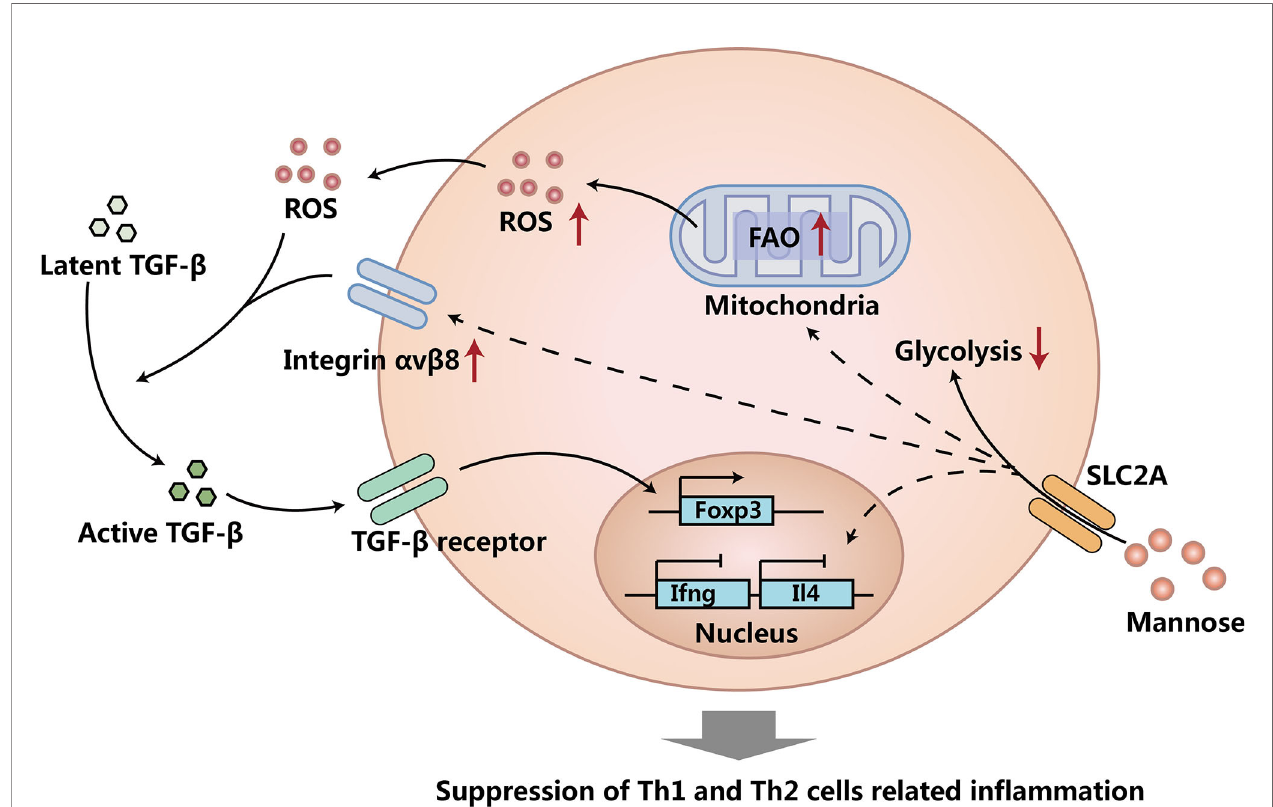
FIGURE 1 | Mannose induces Treg cells and suppresses Teff cells. Mannose suppresses glycolysis, increases fatty acid oxidation (FAO), and up-regulates integrin a b + T cells. Increased FAO caused more reactive oxygen species (ROS) production. The increased ROS and up-regulated integrin a v 8 in CD4 transforming growth factor beta (TGF- b ) from its latent form. TGF- b induces more Treg cells, suppresses Th1 and Th2 cells, and causes the suppression of Th1 and Th2 cells related to in fl ammation. Mechanisms of Treg cell and TGF- b independent Th1 and Th2 cell suppression caused by mannose treatment needs to be further